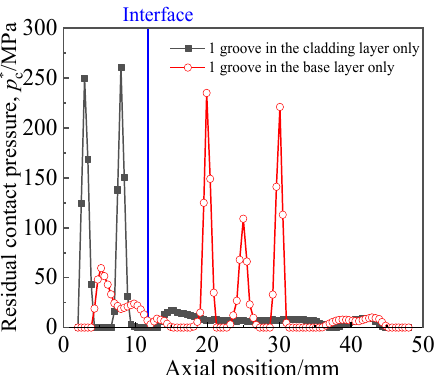
Figure 13. Axial distribution of residual contact pressure.